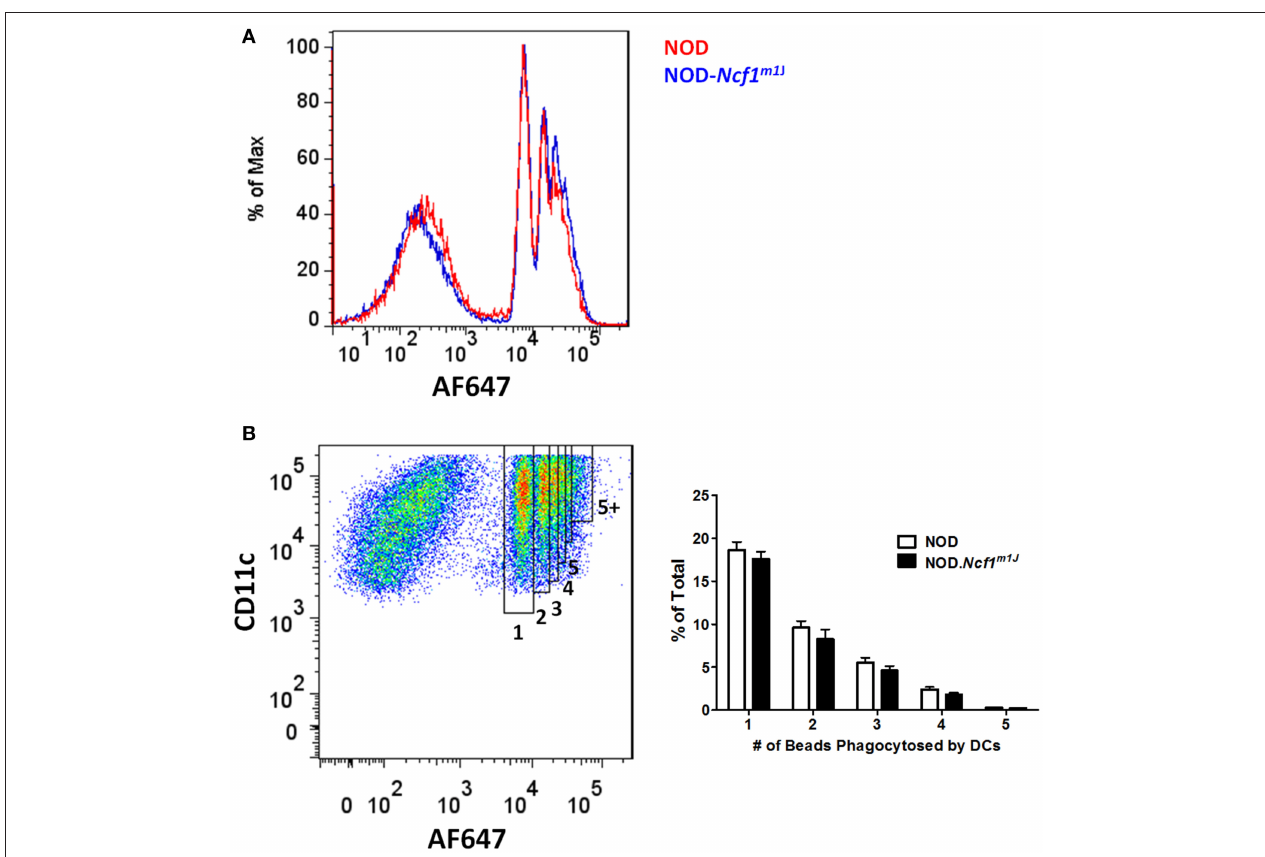
FIGURE 3 | Normal antigen uptake in NOD- Ncf1 m1J DCs. (A) Representative histogram of DCs phagocytized different numbers beads. DCs from NOD or NOD- Ncf1 m1J were incubated with AF647 conjugated latex beads for 15min and cells were analyzed by FACS after 3 washes. (B) Gating strategy and quantitation of DC phagocytosis. Each bar graph is representative of three independent experiments performed in triplicates.